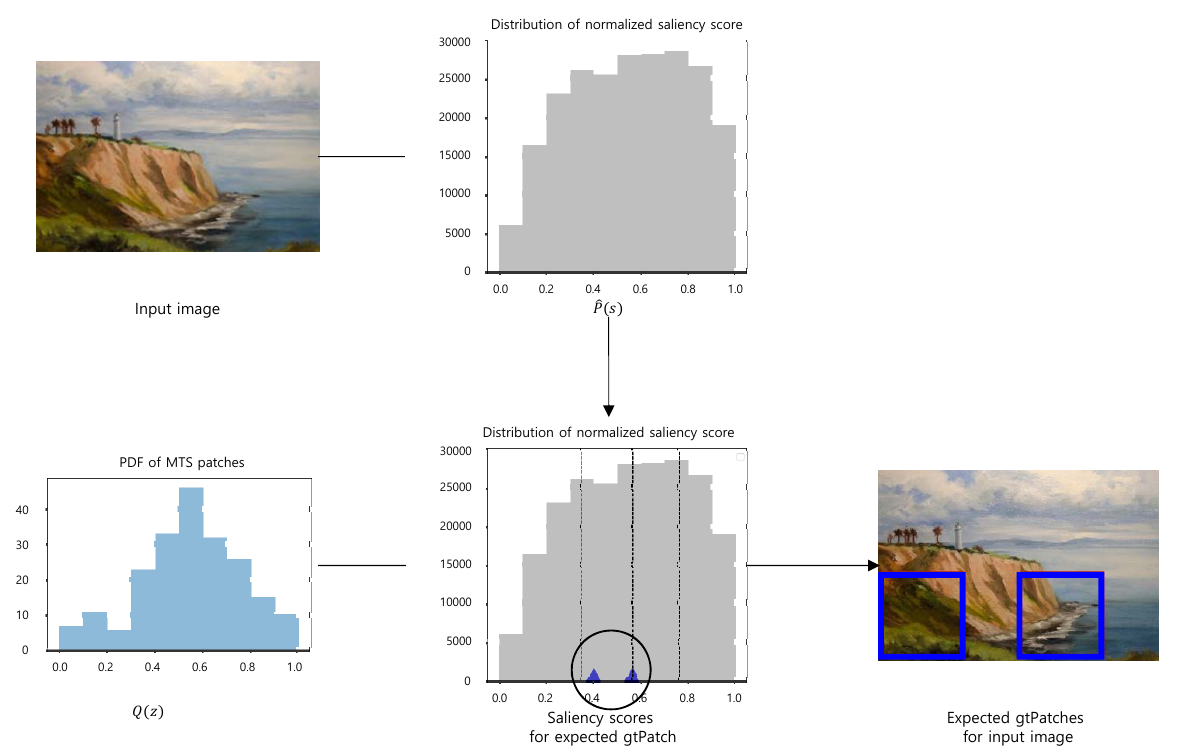
Figure 8. Estimating normalized distribution of saliency